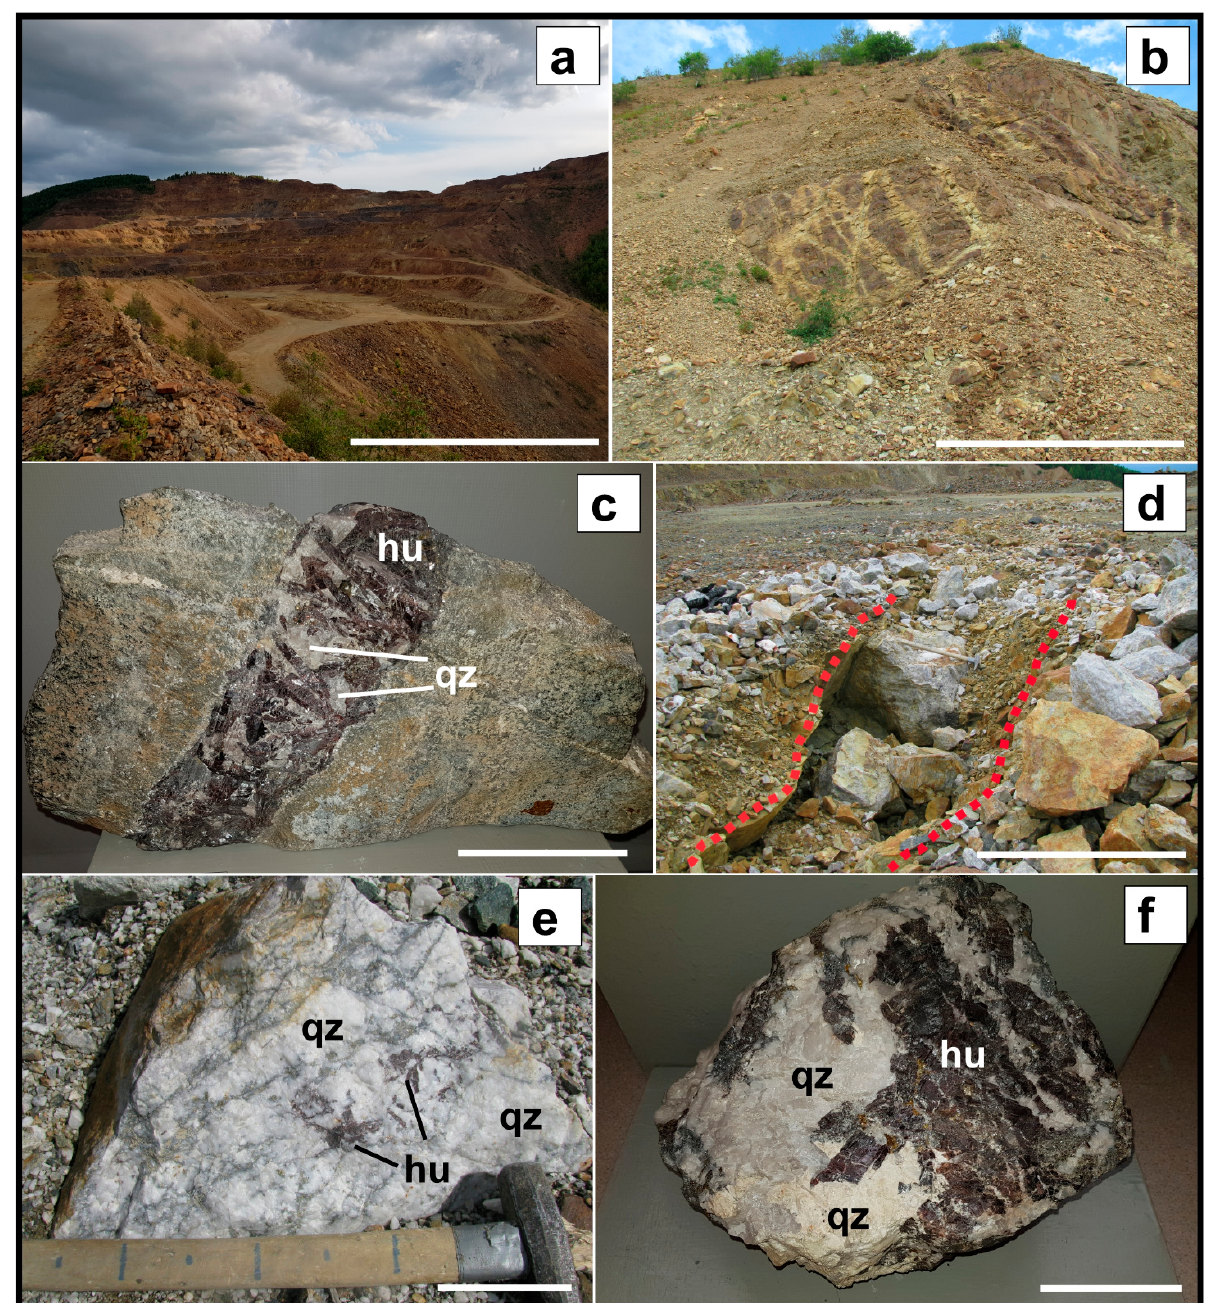
Figure 2. ( a ) General view of the Inkur quarry; ( b ) Inkur stockwork; ( c ) a hubnerite-rich quartz veinlet; ( d ) quartz-hubnerite veins of the Kholtoson deposit (red dotted line); ( e ) a sample of a quartz-sulfide vein with hubnerite (Kholtoson deposit); ( f ) rich quartz-hubnerite vein of the Kholtoson deposit. The samples in figures ( c , f ) are from the Geological Museum of the Buryat Scientific Center SB RAS, Ulan-Ude. Abbreviations of the minerals: hu—hubnerite, qz—quartz. Scale bar length: ( a,b ) 5 m, ( c,f ) 5 cm, ( d ) 1 m, ( e ) 10 cm.